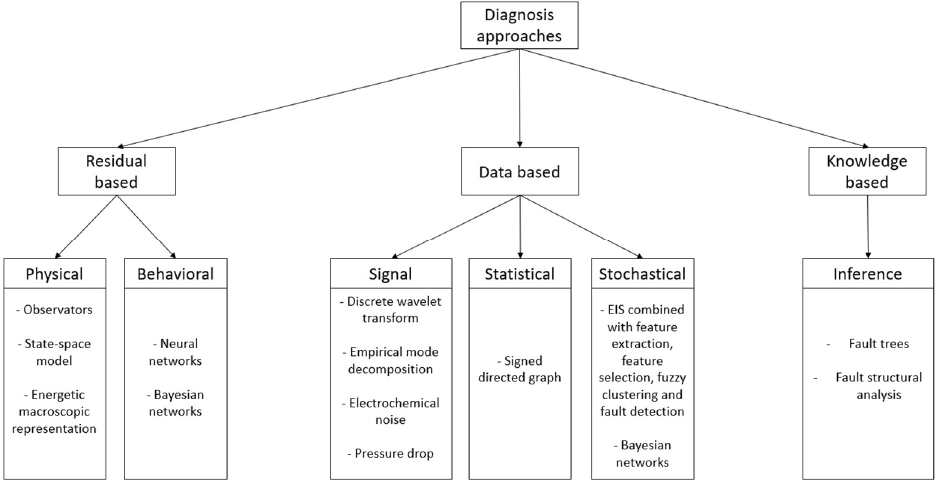
Figure 1. Possible approaches for diagnostic tool development [1].